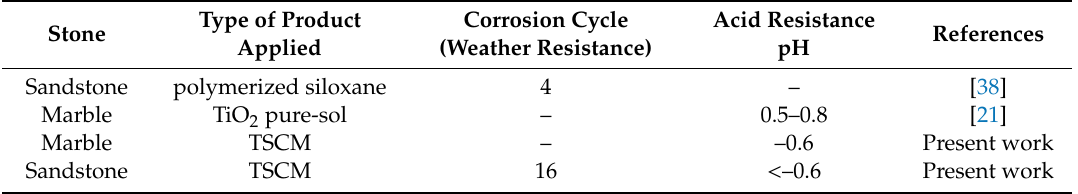
Table 3. Comparison of protection performance between this work and other